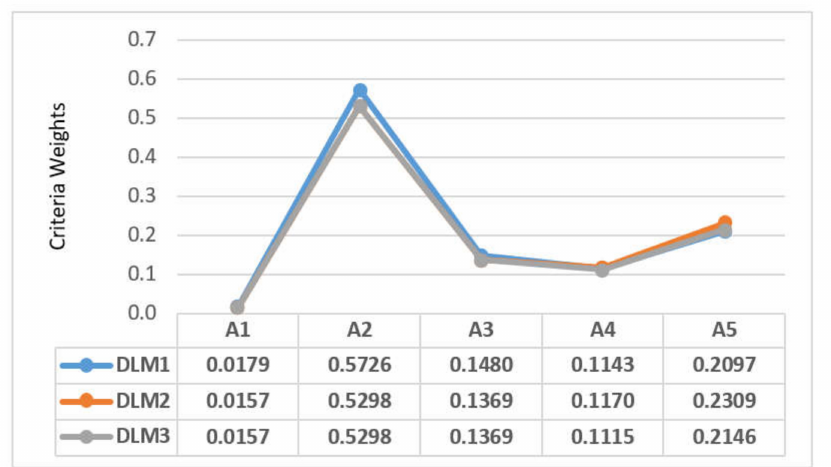
Figure A1. The study results of quality assessment for three distance learning modules—DLM1, Research methodology and statistical analysis; DLM2, Social Statistics; DLM3, Political